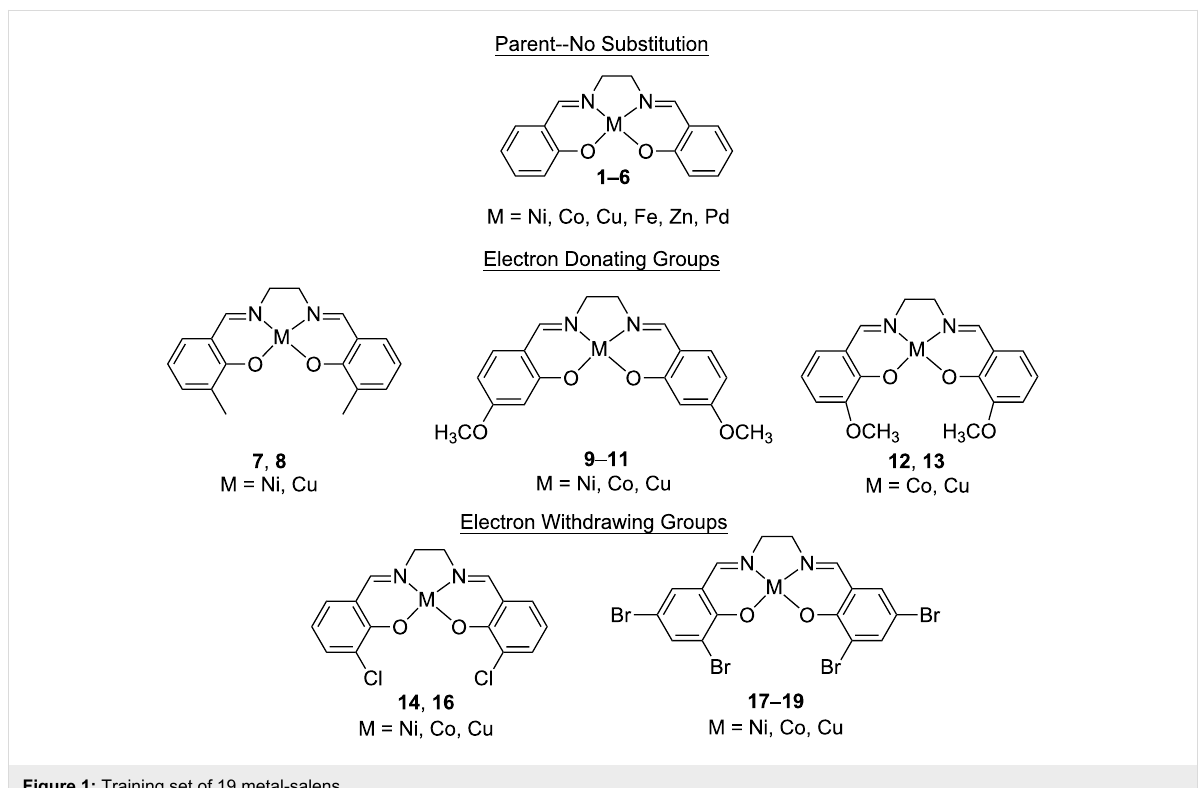
Figure 1: Training set of 19